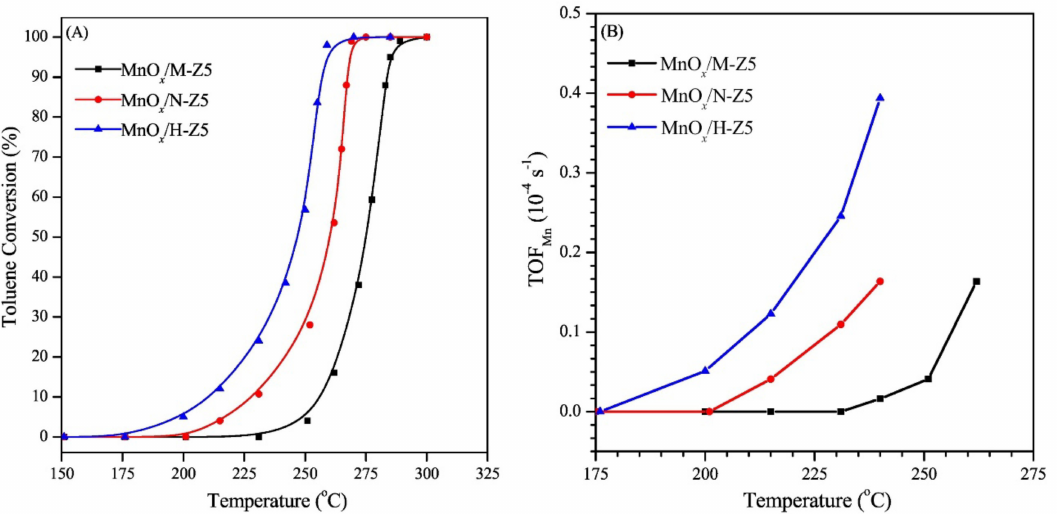
Figure 29. Catalytic conversion ( A ) and TOF ( B ) as a function of the reaction temperature. Adapted with permission from Reference [173]. Copyright (2019) Elsevier B.